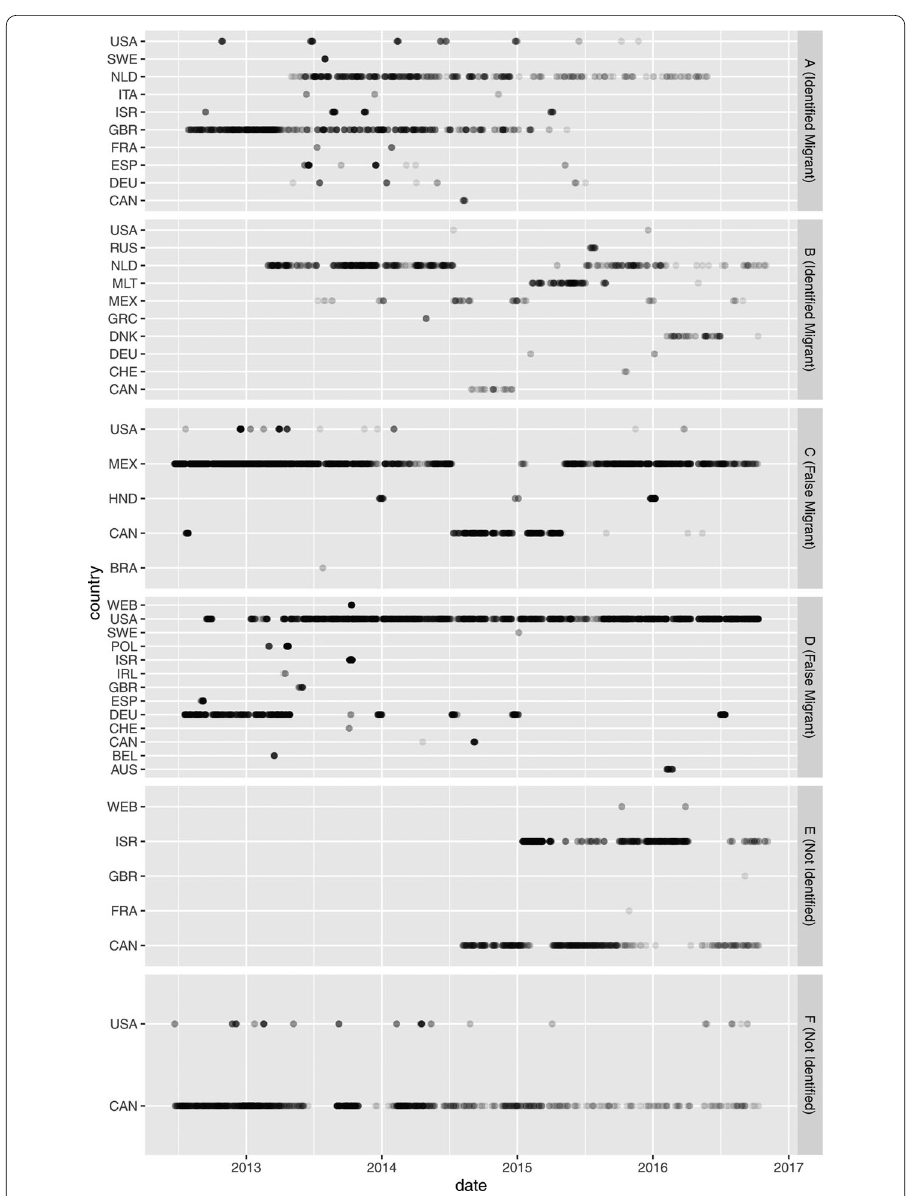
Figure 3 We present the geolocated Twitter timelines of 6 representative Twitter users. We observe that tweet behaviour is bursty, and that users take many short trips to other locations. Users A–D were classified by both algorithms as migrants, however only users A and B were confirmed by our annotators to display an actual migration event. UserA mentions directly moving to Amsterdam from Great Britain, while travelling for business. At one point they mention (paraphrased), “maybe one day I’ll be at my new home for more than 2 days!”. This user is a migrant, but seemingly geo-located in both the Netherlands and Britain over an extended period. UserB was identified as a student migrant. While both algorithms identified several moves, only the initial move from the Netherlands to Mexico was identified by our annotators as a true migration event. In both cases, it is possible that a user was using a VPN to access restricted content from another country. UserC is a resident of Canada originally from Mexico. Despite the geolocation of the tweets, there was no mention of the user actually being in Mexico, or moving back to Canada. UserD likely moved from Germany to the United States, however due to the overlap in time periods, neither algorithm identified the correct move window: during the time window flagged as the time of move the user had not yet made the move to the United States, but had only returned for a brief family visit. The algorithm was, however, correct in principle. Finally, users E and F were not identified as migrants by either of the algorithms. UserE is an artist who often travels to Israel to paint, but mentions living in Montreal, Canada. UserF is a business professional who takes occasional trips to the United States for